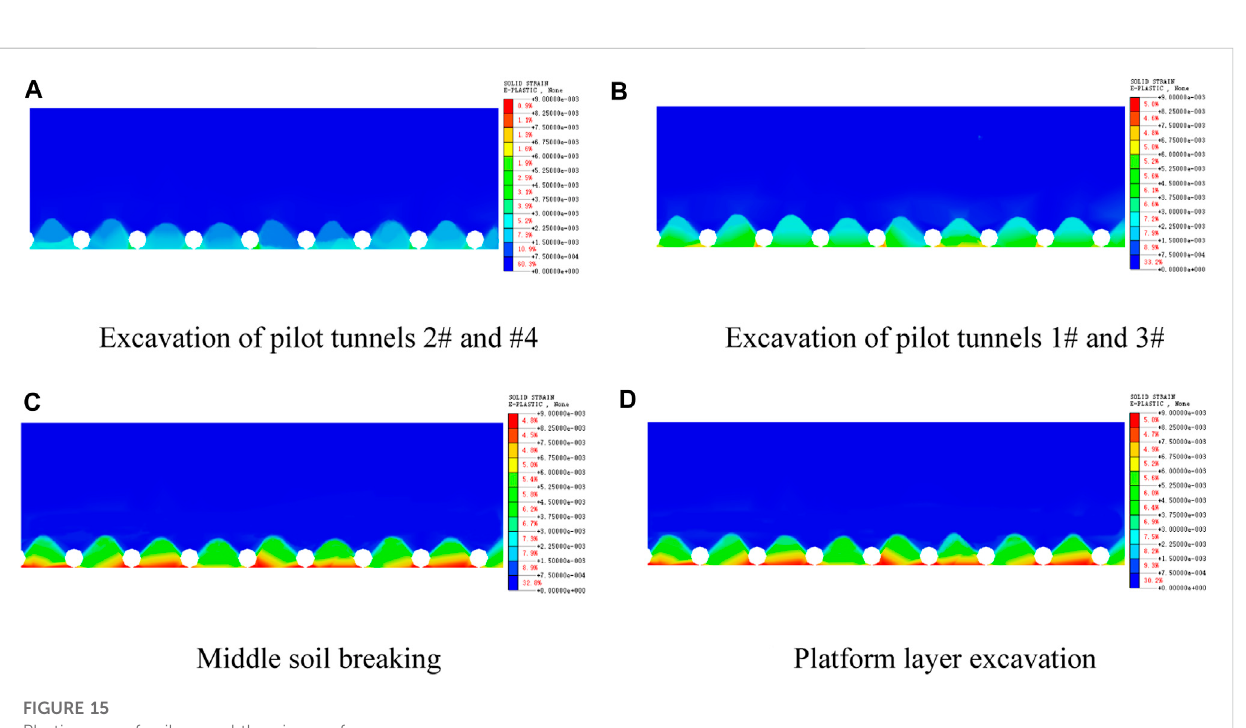
FIGURE 15 Plastic zone of soil around the pipe